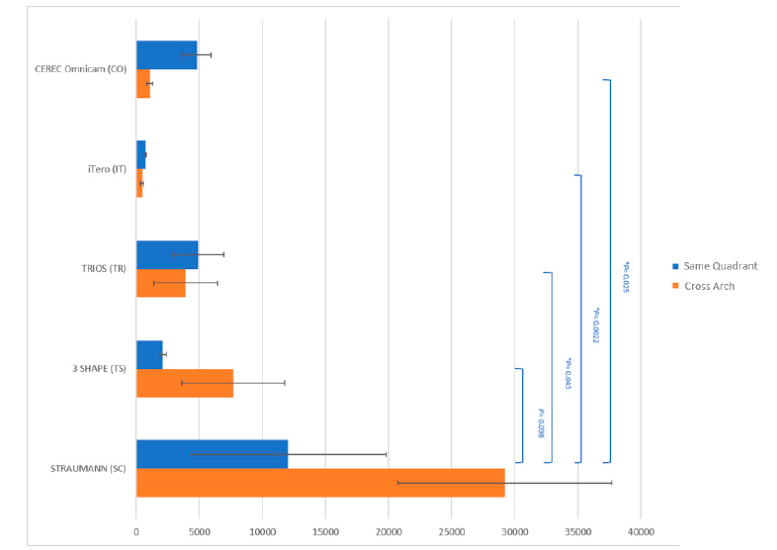
Figure 7. Precision of distance measurements using di ff erent scanners (same quadrant vs. cross arch). Inverse of the square of variance (1/ σ 2 ).